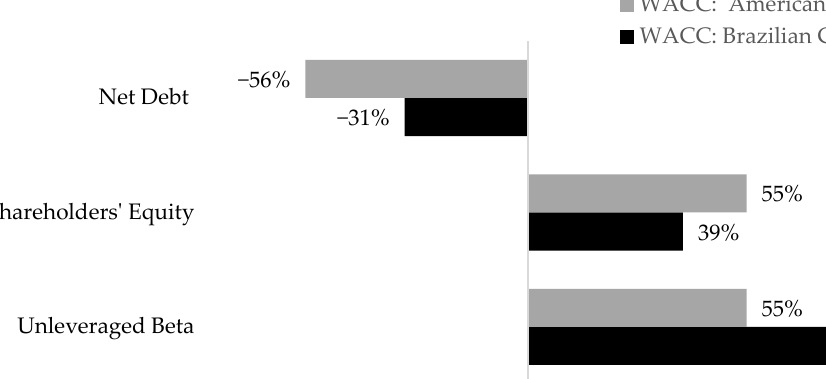
Figure 2. Influence of the uncertainty variables of the Brazilian and American companies in relation to the cost of capital (WACC) of the fuel oil thermoelectric plant.